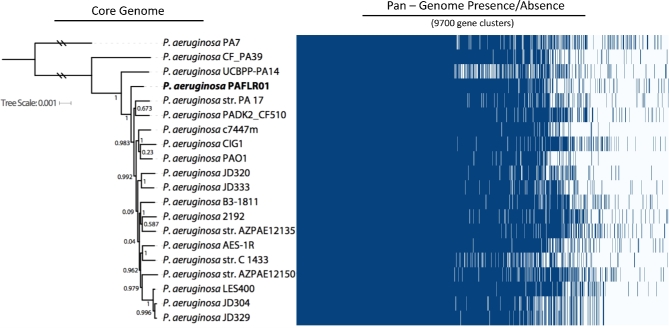
Phylogenetic tree and heatmap based on the core and pan-genome, respectively, of 20 P. aeruginosa common lab and CF isolates. One thousand three hundred sixty-nine genes are shared at 90% average AAI across 90% of the protein sequence. Values next to branches indicate bootstrap scores. Blue and white bars, respectively, represent presence and absence of genes across all 20 strains.